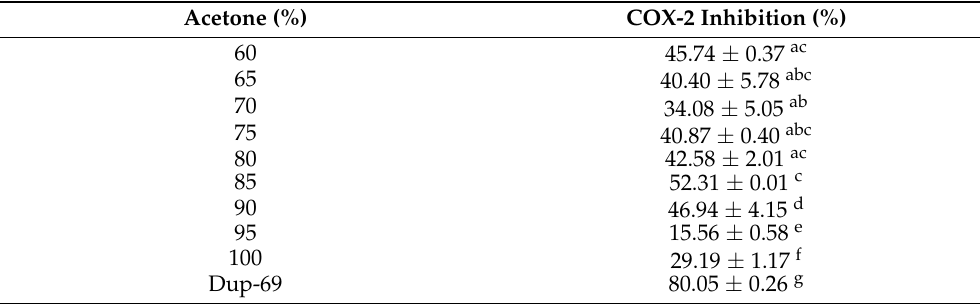
Table 4. In vitro anti-inflammatory activity of Quince fruit ( Cydonia oblonga Mill.) extracts.